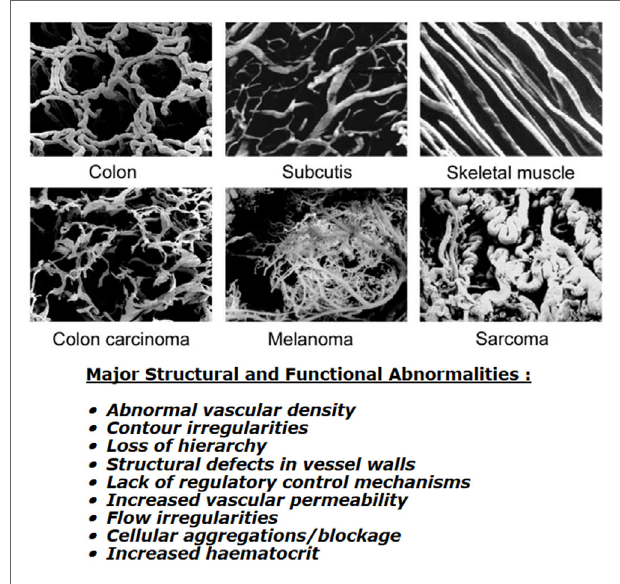
FiGURe 1 | vascular casting images showing differences in microcirculation between normal tissues (top three panels) and malignant tumors (lower three panels) . Specific details of the corrosion casting technique used to produce these images can be found in Konerding et al. (14). Images shown were obtained courtesy of Prof. Konerding, Dept. Functional and Clinical Anatomy, University Medical Center, Mainz, Germany and are from Vaupel (10). Bottom text lists the major structural and functional abnormalities of tumor vessels when compared to normal tissues; composite information based on work by Kimura et al. (12), Reinhold and van der Berg-Blok (15), Vaupel et al. (10, 16), and Baronzio et al. (17).